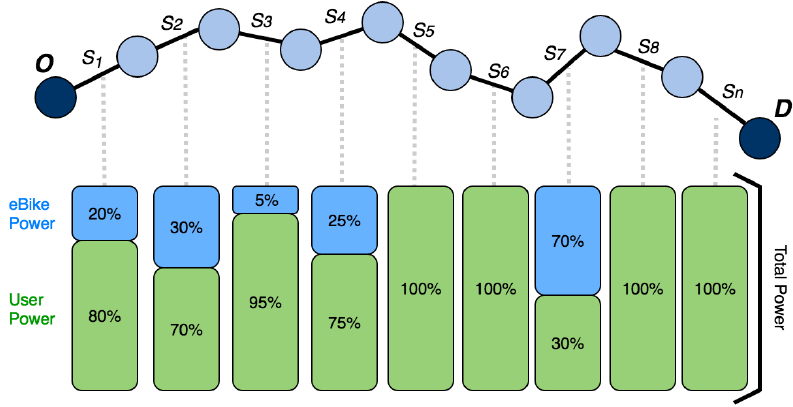
Figure 6. Example of how power is distributed for each of the segments of a route.